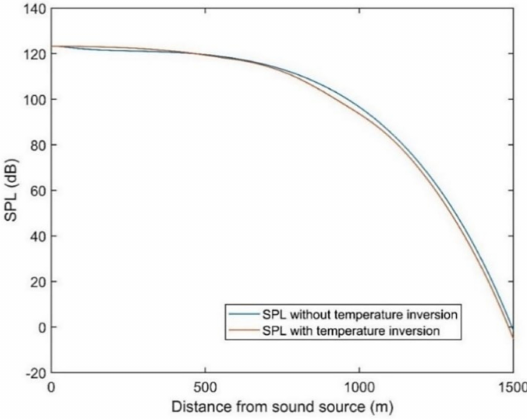
Figure 5. Variation of SPL with distance from sound